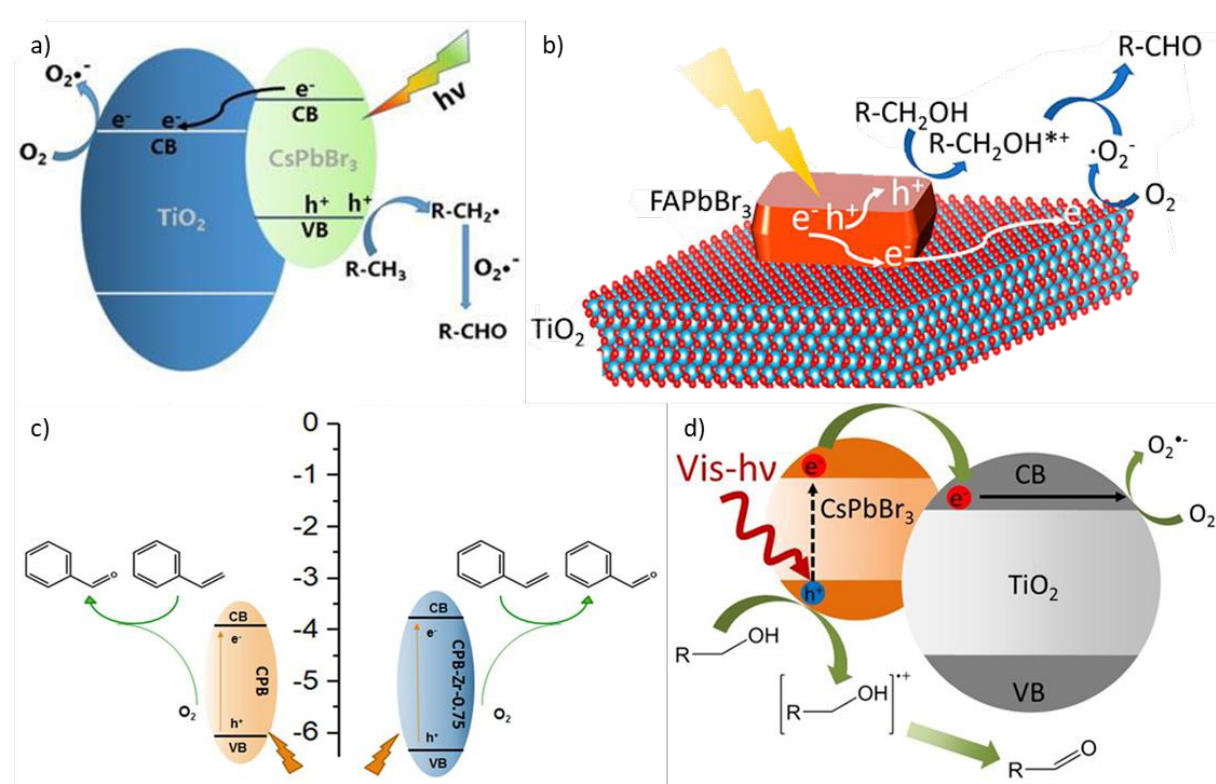
Figure 3. Proposed reaction mechanisms: ( a ) for the oxidation of toluene to benzaldehyde. For details, see ref [32]. Reprinted with permission from ref [32]. Copyright 2020 Kin. J. Chem. ( b , d ) for the oxidation of benzyl alcohol to benzaldehyde. For details, see refs [31,33]. Reprinted with permission from refs [31,33]. Copyright 2018 ACS Energy Letters. Copyright 2018 ChemSusChem. Ref. [33] is available online at: https://pubs.acs.org/doi/full/10.1021/acsenergylett.8b00131 (Accessed on 12 July 2021) ( c ) for the oxidation of styrene to benzaldehyde. For details, see ref [35]. Reprinted with permission from ref [35]. Copyright 2020 Frontiers in Chemistry.